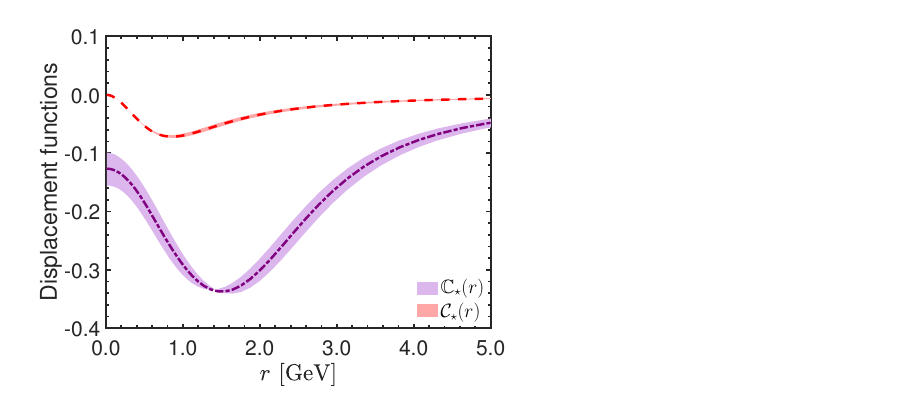
Figure 7. The solutions for C (cid:63) ( r ) (purple dot-dashed) and coupled BSE system of Equation